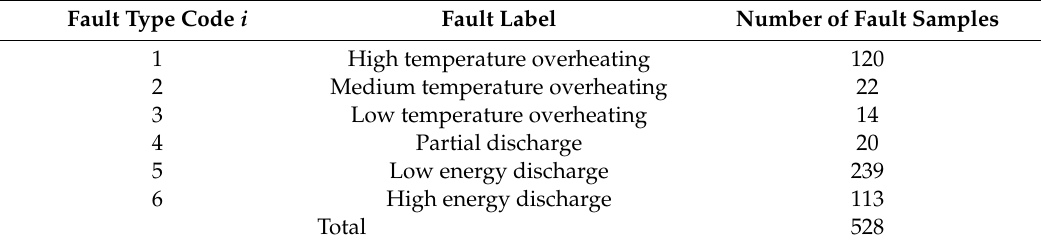
Table 1. Distribution of the original dataset.